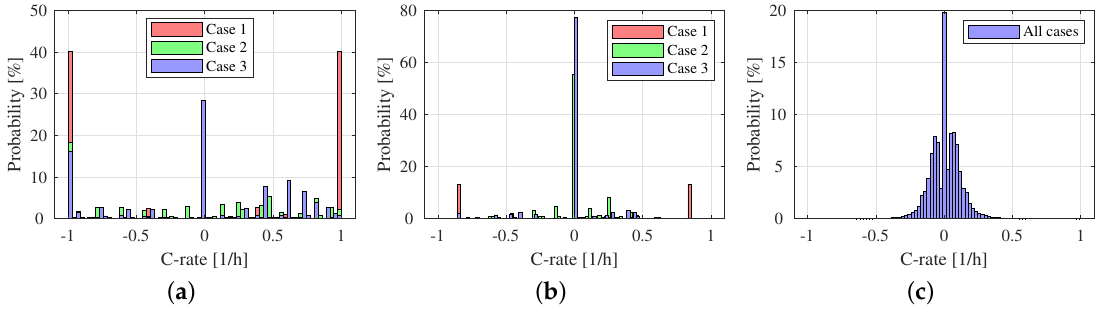
Figure A2. Histogram plots of C-rate for ( a ) the intraday market; ( b ) the day-ahead market; and ( c ) the primary control reserve.